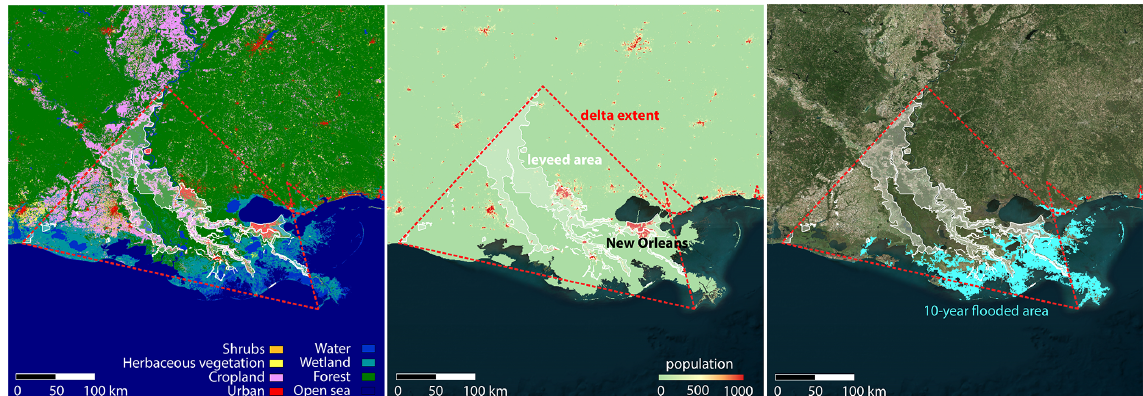
Figure 5. Examples of land use (Copernicus Global Land Service, Buchhorn et al., 2020), population (LandScan, https://landscan.ornl.gov/, last access: 1 October 2022), and flooded area (Dullaart et al., 2021) within and outside levees in the Mississippi Delta.